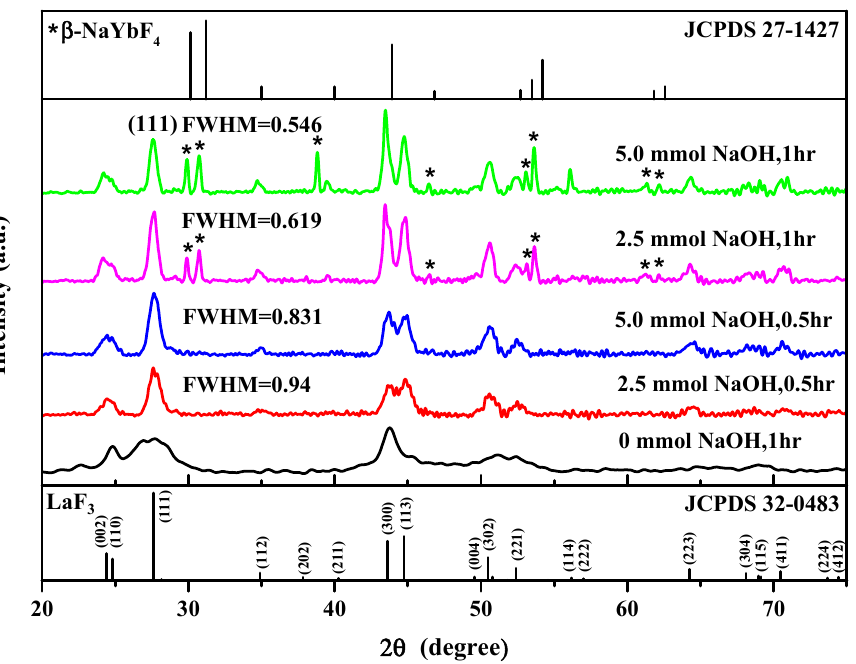
Figure 1. X-ray di ff raction analysis of LaF 3 :Yb 3 + 0.20 , Er 3 + 0.02 synthesized by di ff erent reaction parameters (*: β -NaYbF 4